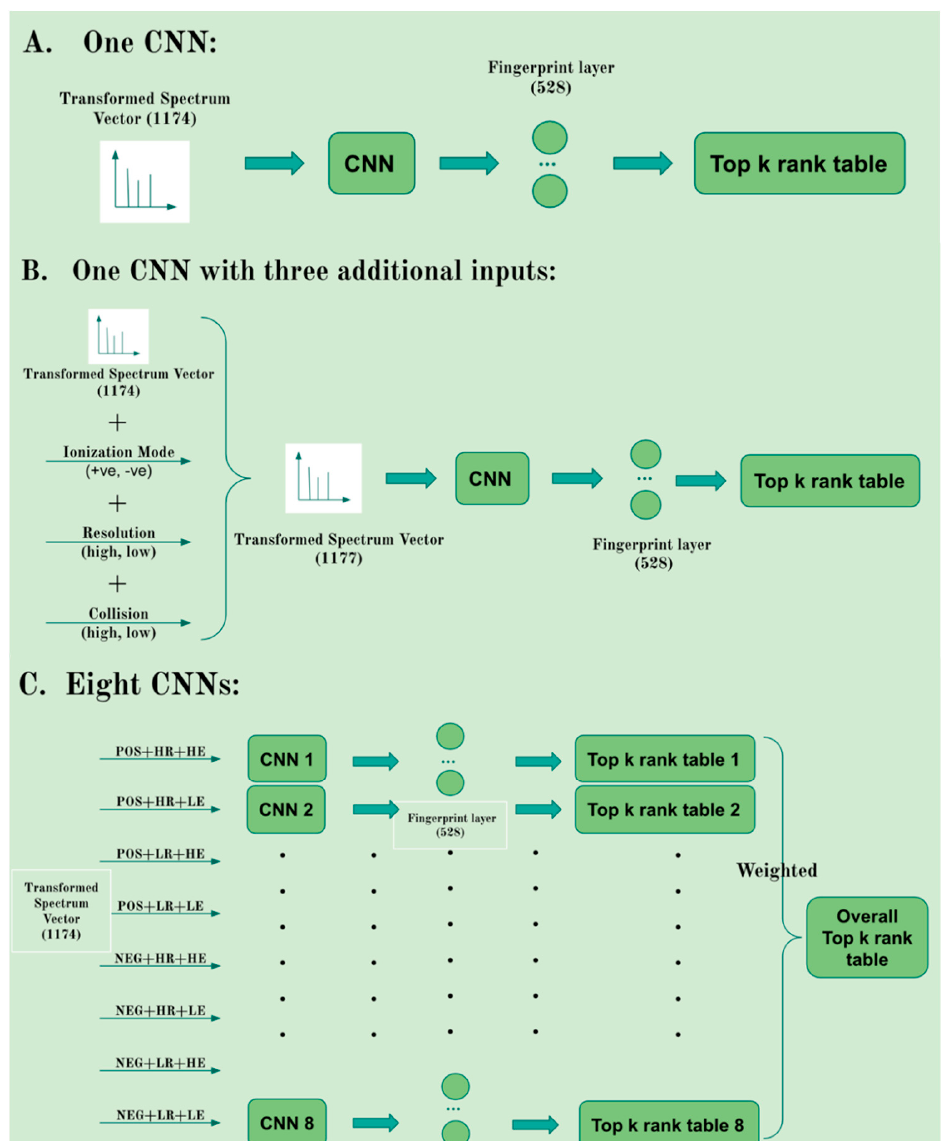
Figure 3. Three different strategies of the CNN model. ( A ) One CNN model with only ion intensity values as input. ( B ) One CNN model with ion intensity values and three additional inputs. ( C ) Eight CNN models each trained with a subset of the MS/MS spectra.